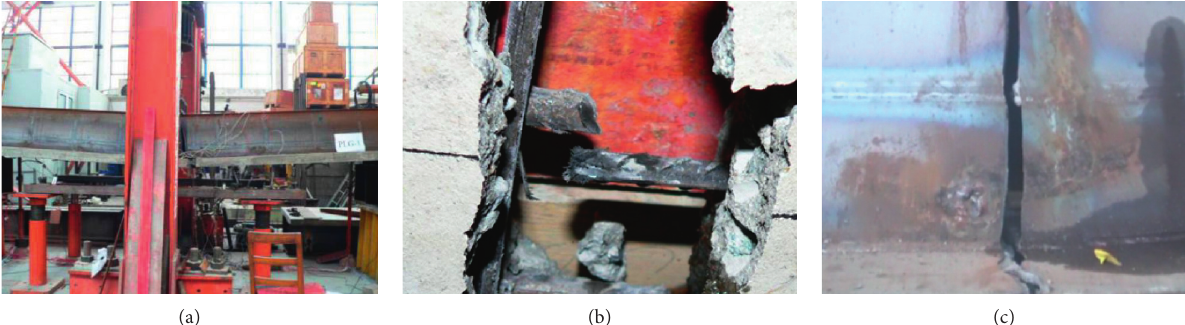
Figure 14: Failure mode of PLG-1. (a) Global failure of composite beam. (b) Failure of reinforcement. (c) Failure of steel beam.